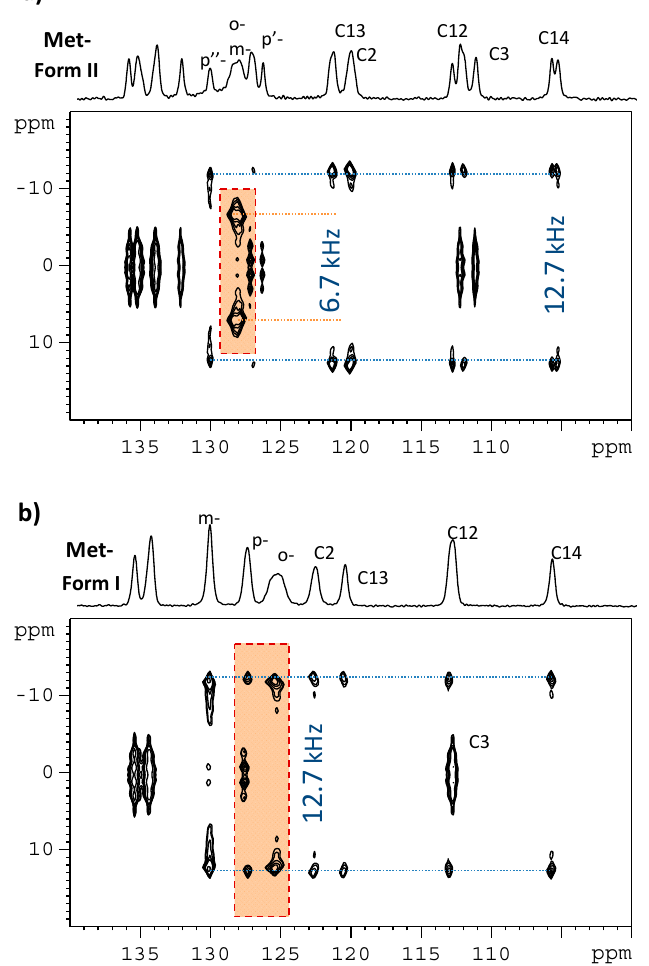
Figure 5. Expanded regions of 2D 1 H– 13 C PISEMA NMR spectra for polymorphs MI and MII in panels ( a , b ), respectively. Upper projections are provided by 1D 13 C CP/MAS NMR spectra. For full-size spectra see Supporting Information (SI-Experimental details.pdf).